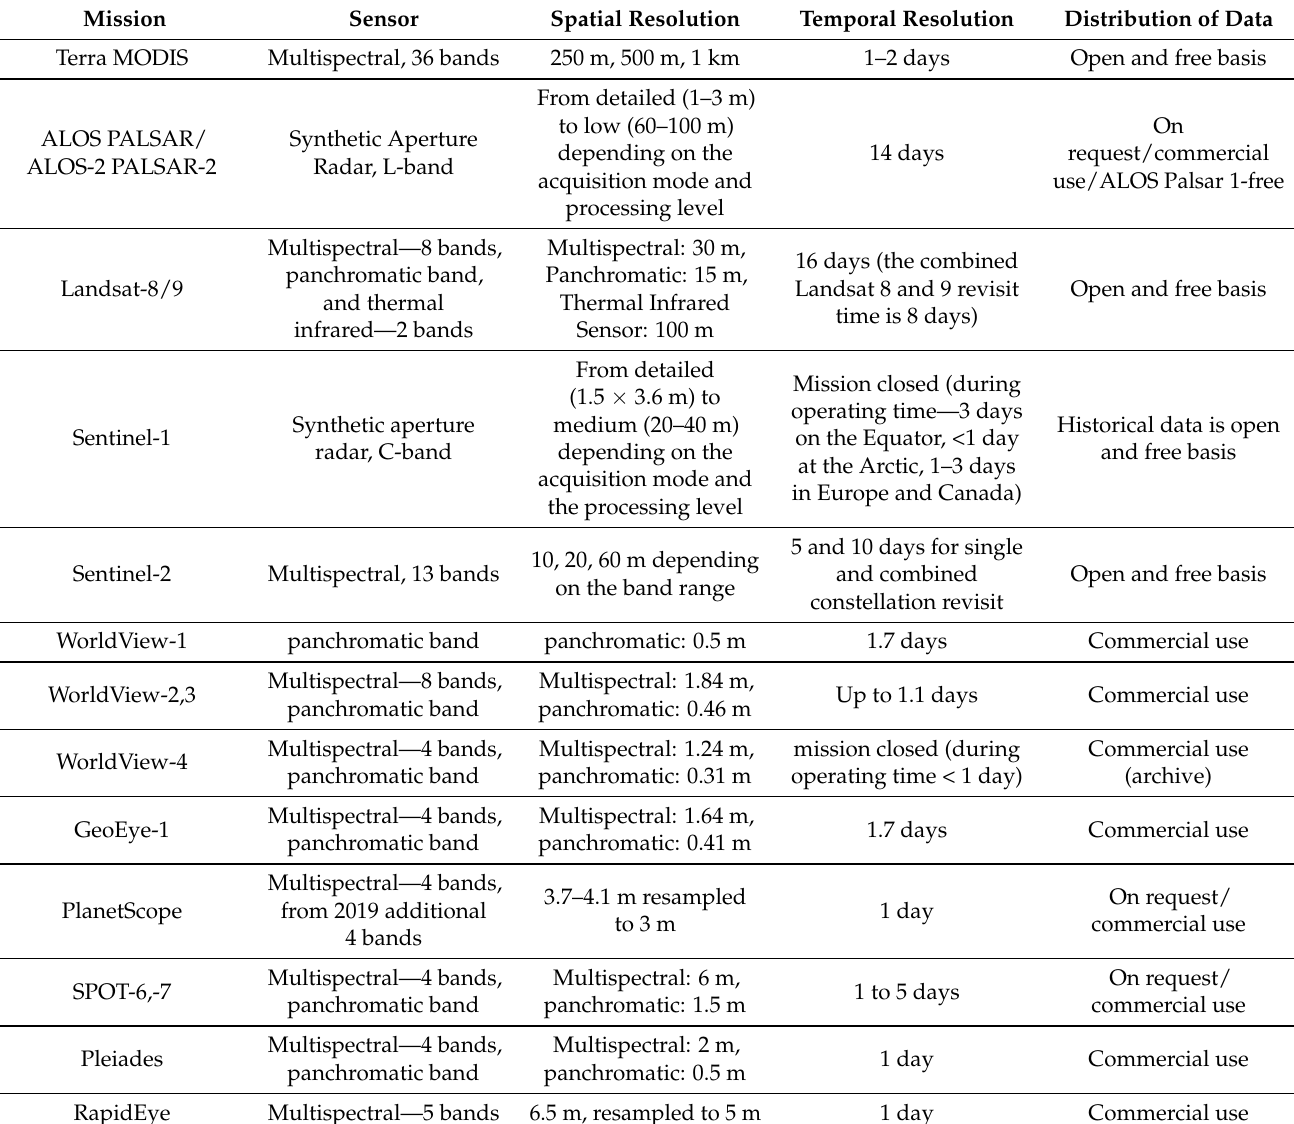
Table 1. Commonly used instruments of remote sensing data acquisition and distribution, and their characteristics aggregated from [19,31–37] and missions’ technical websites